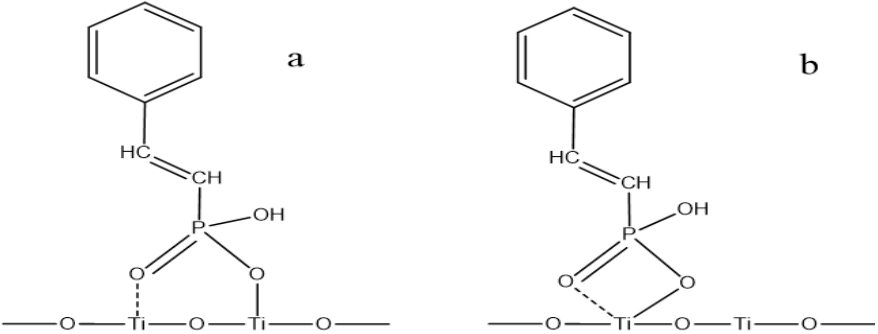
Figure 7. The conjecture of SPA adsorption on the surface of the rutile particle: ( a ) one SPA molecule binds two Ti atoms; ( b ) one SPA molecule binds to one atom.